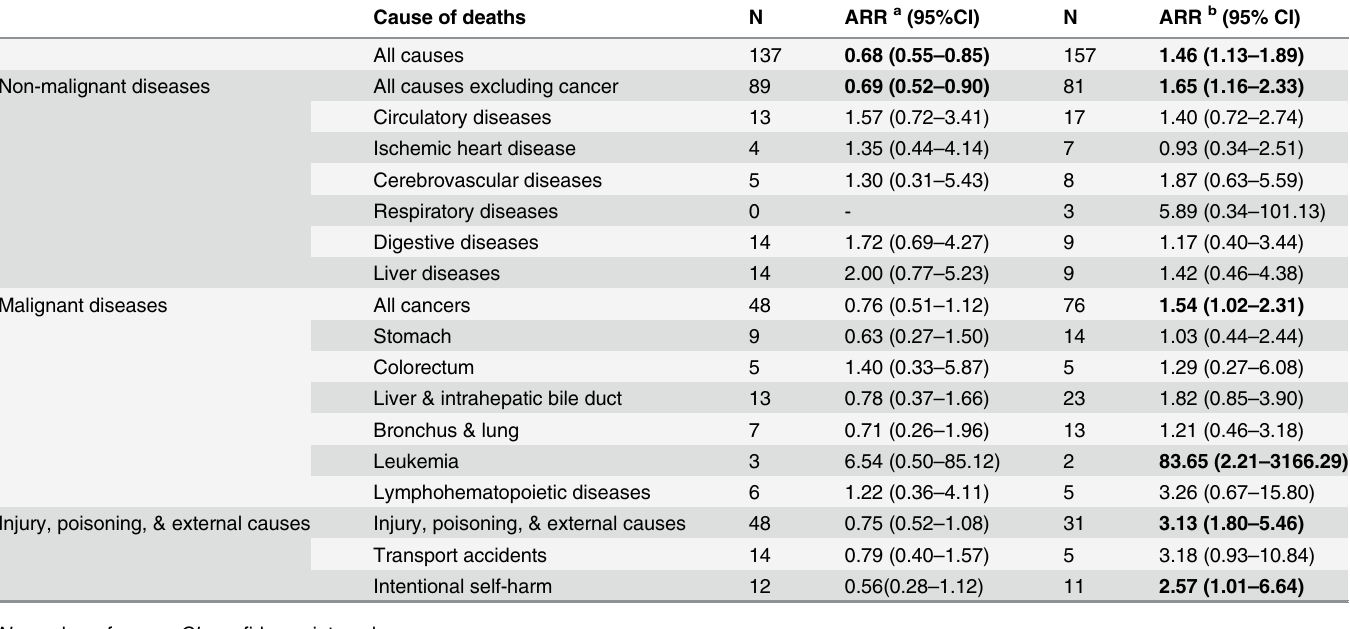
Table 4. Adjusted relative risk (ARR) of mortality of fi re fi ghters (reference: never- fi re fi ghters and fi re fi ghters employed < 10